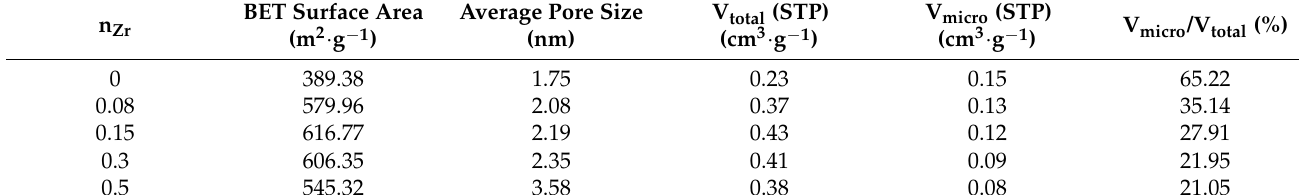
Figure 8. ( a ) The nitrogen adsorption-desorption isotherms and ( b ) the corresponding pore size dis- tribution curves for the ZrO 2 -MSiO 2 materials with various n Zr . Table 1. Pore structure parameters of the ZrO 2 -MSiO 2 materials with various n Zr .